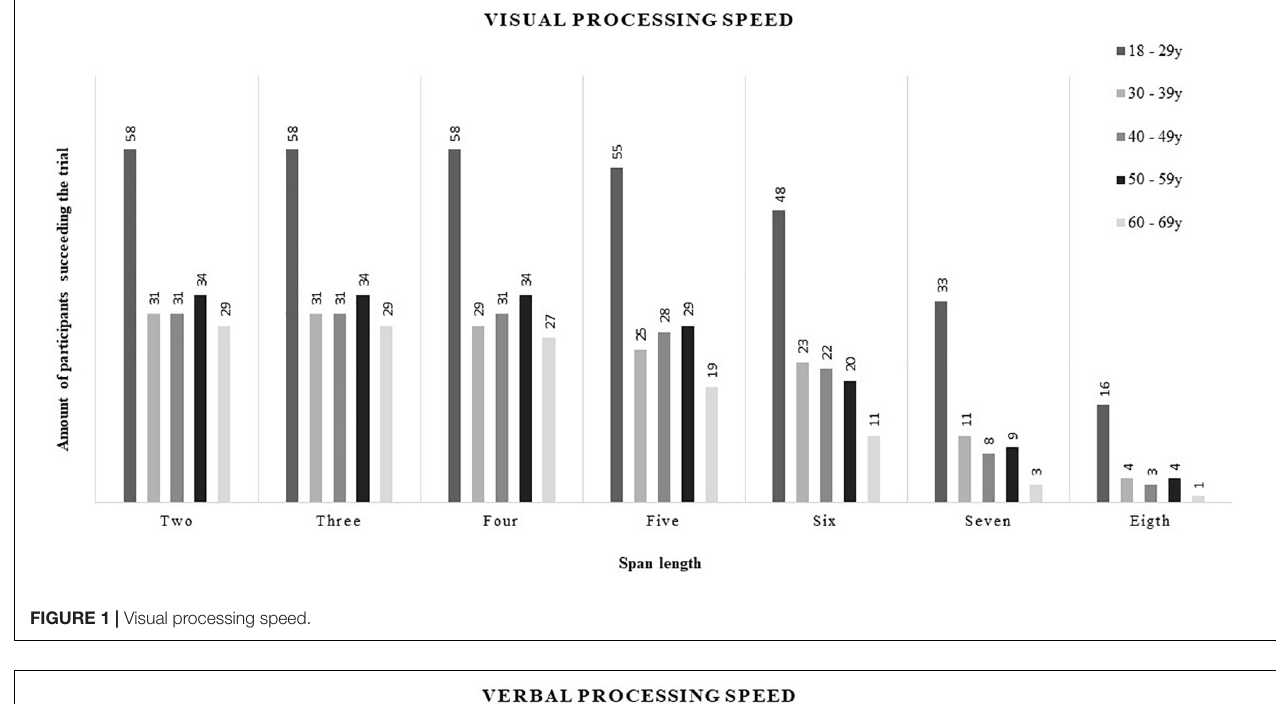
FIGURE 1 | Visual processing speed.